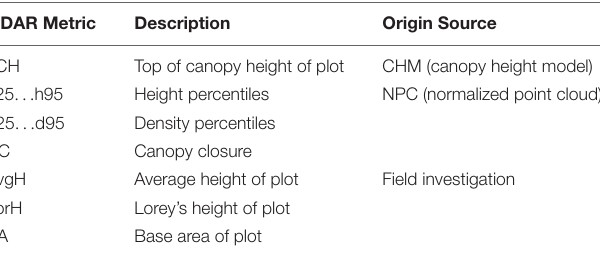
TABLE 1 | Metrics derived from LiDAR and field investigation